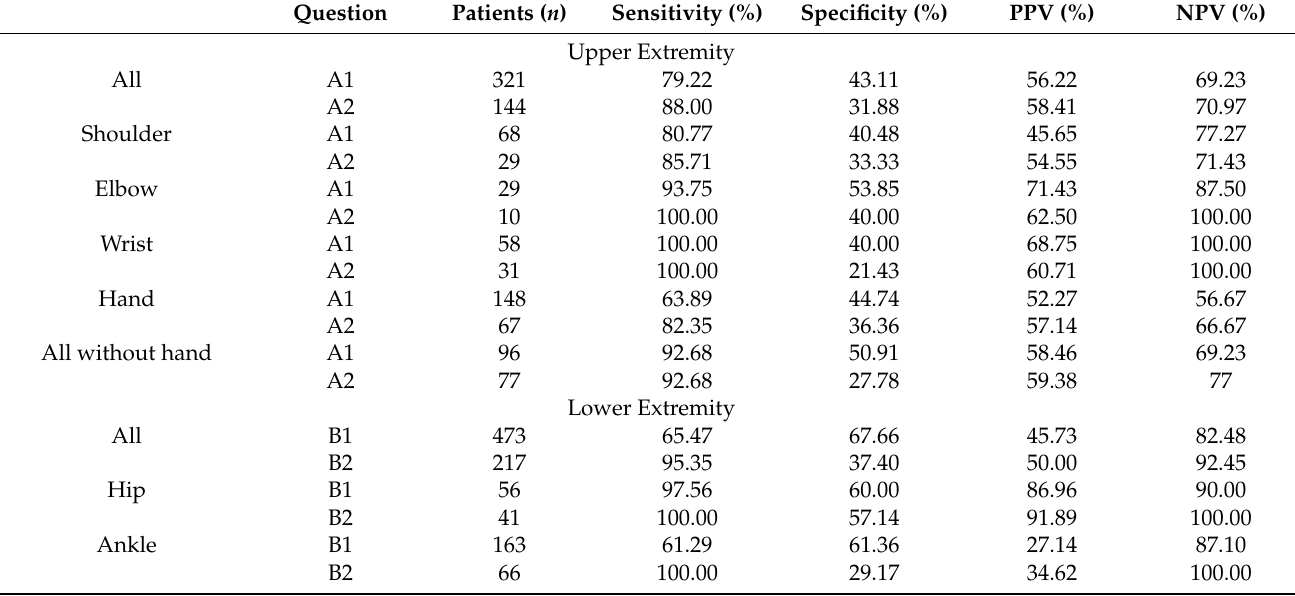
Table 2. The sensitivity, specificity, PPV, and NPV of questions A1 and A2 for the UE (all, wrist, shoulder, elbow, and hand) and of questions B1 and B2 for the LE (all, hip, ankle, knee, and foot), complete and without hand injuries (A1, A2) and without foot injuries (B1, B2).